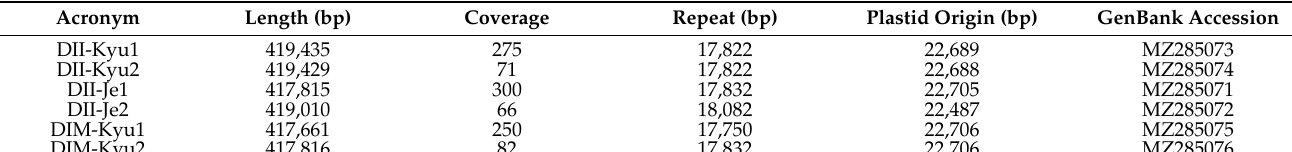
Table 2. Mitochondrial genome assembly statistics of six individuals of Damnacanthus indicus .